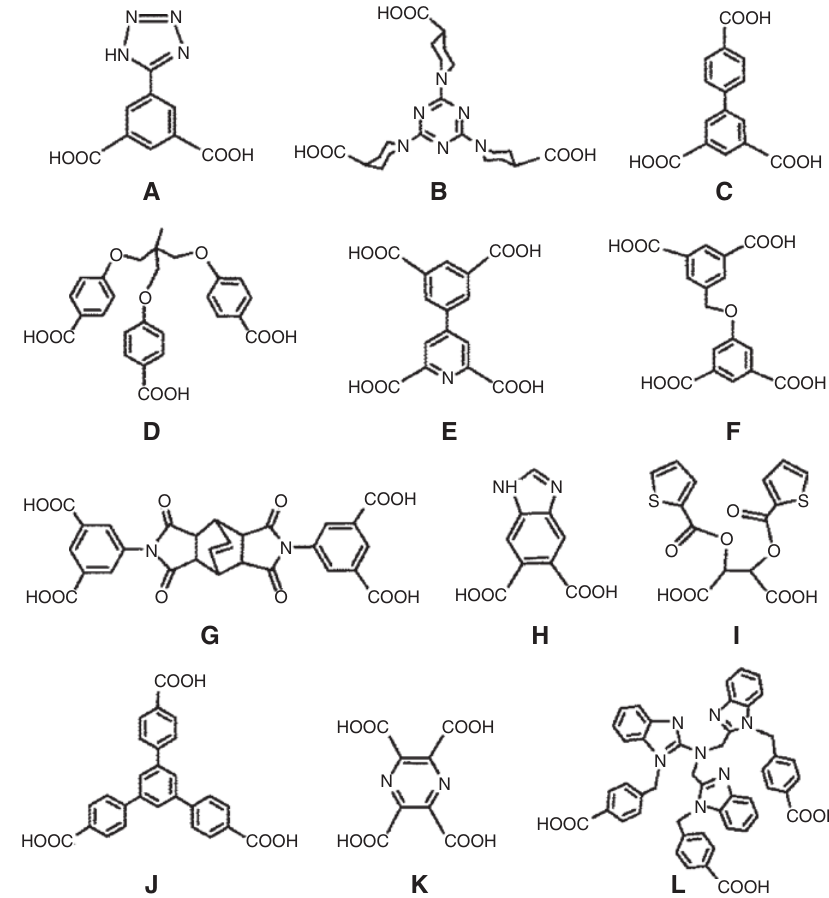
Figure 2: Some aromatic polycarboxylate ligands. (A) H TIPA; (B) H 2